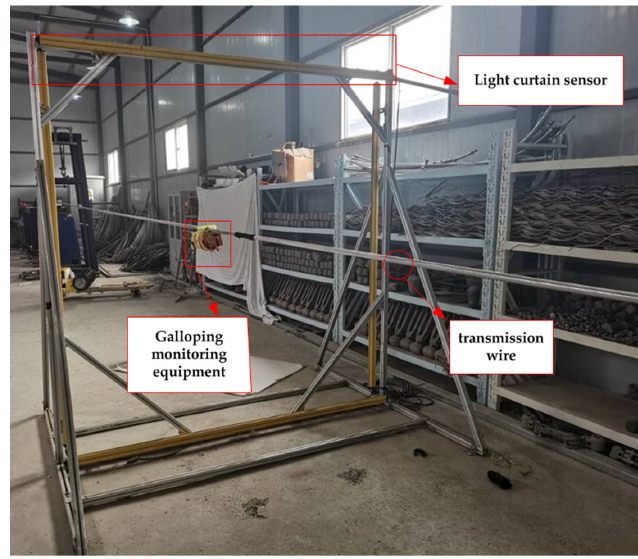
Figure 13. Conductor galloping experimental equipment.